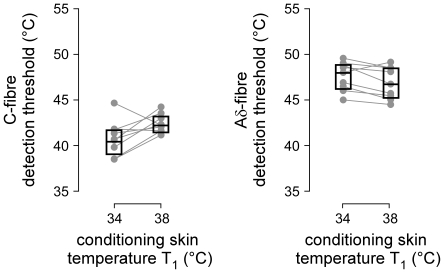
Thermal detection threshold of the behavioural responses triggered by Aδ- and C-fibre input obtained when the stimulated area is first heated to T1 = 34°C or T1 = 38°C during the two seconds preceding the test stimulus (T2).The thin grey lines represent the individual thresholds obtained in each participant. The box plots represent the group-level median and interquartile range. Note that the C-fibre threshold is increased for T1 = 38°C vs. T1 = 34°C, whereas the Aδ-fibre threshold appears unaffected by the conditioning skin temperature.